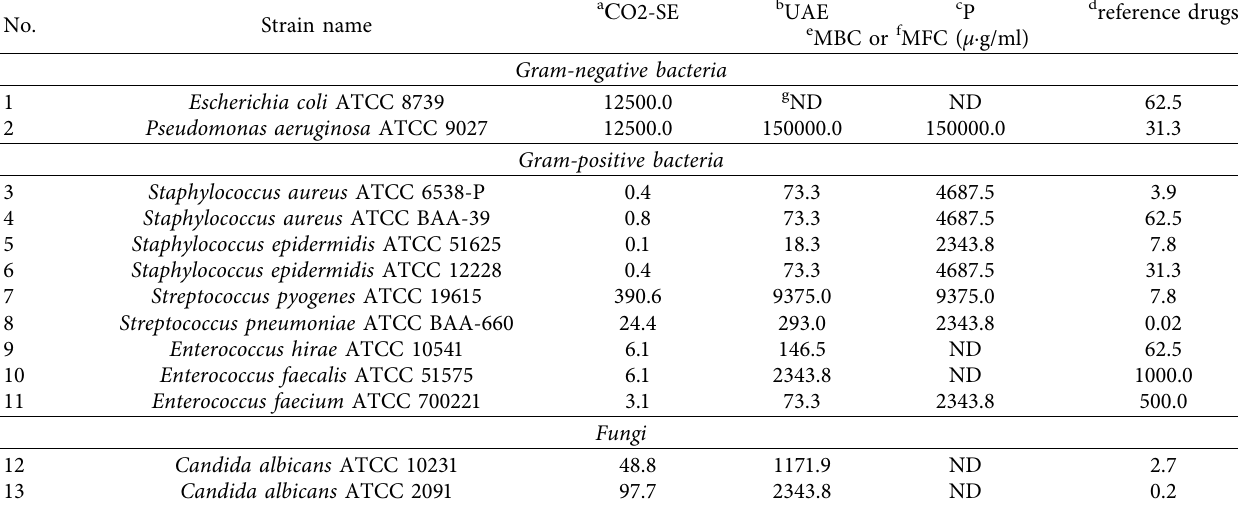
Table 5: The antimicrobial activity results of O. gmelinii extracts obtained by the method of serial dilutions.